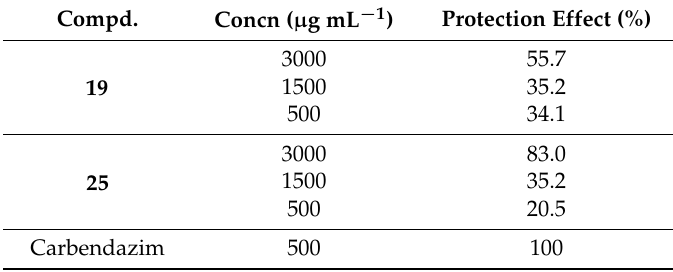
Table 4. In vivo Protective Effects of Compounds 19 and 25 against Sclerotinia sclerotiorum .